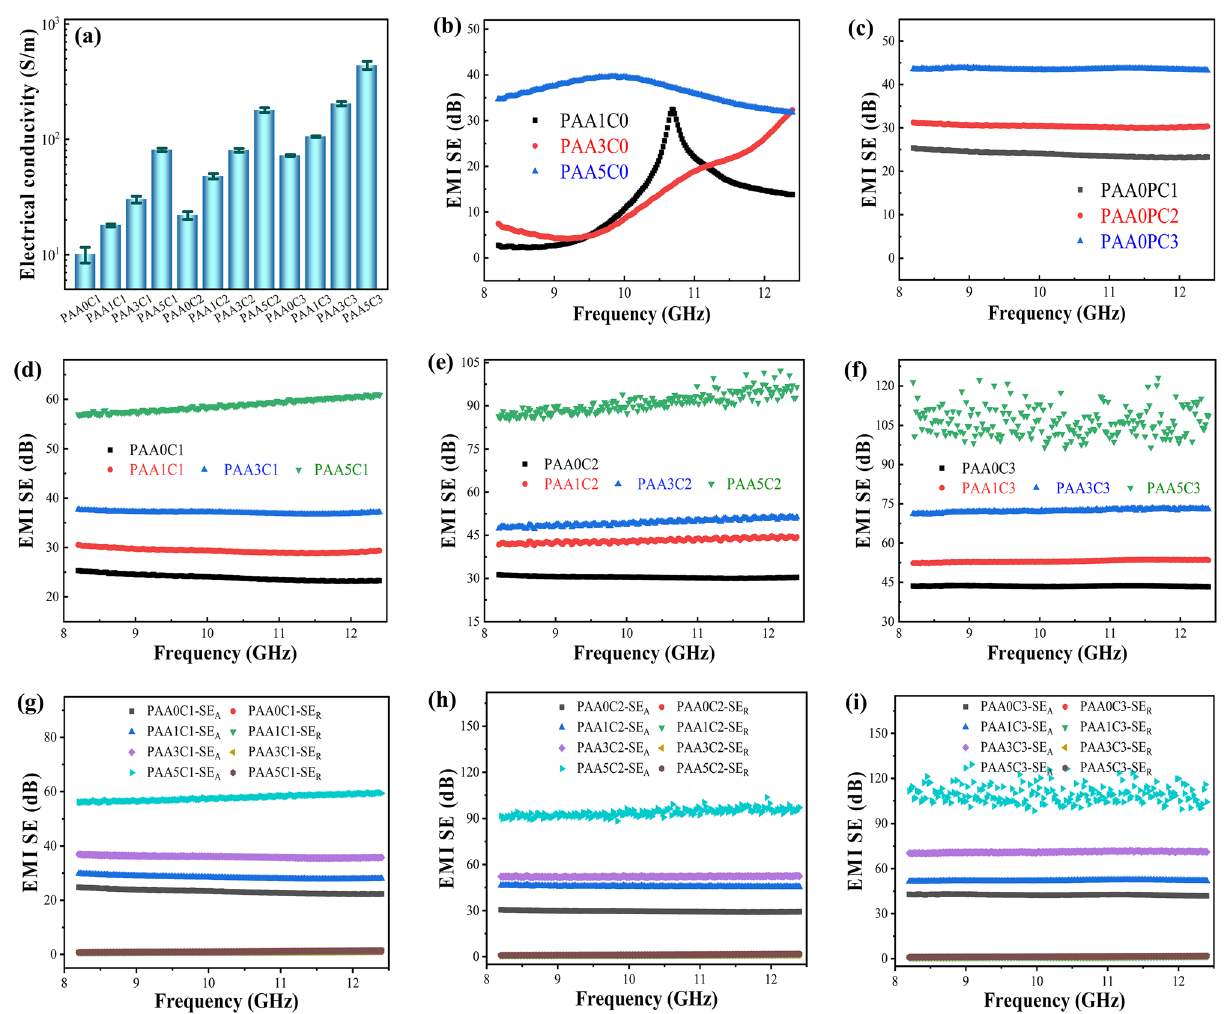
Fig. 3 a The electrical conductivity of the PAAC composites with different AAF and CNT contents; b, c EMI SE of PAAC composites with various single-filled AAF and CNT contents in the X-band; the EMI SE of d PAAxC1, e PAAxC2, f PAAxC3 composites in the X-band fre- quency range; the absorption loss ( SE A ) and reflection loss ( SE R ) of g PAAxC1, h PAAxC2 and i PAAxC3 composites in the X-band frequency